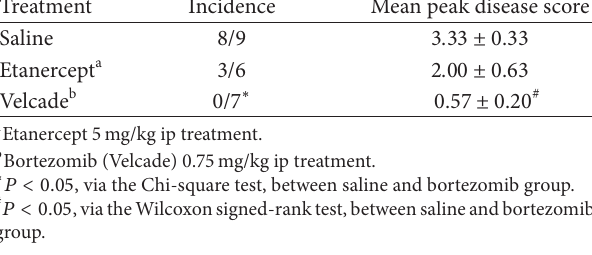
Table 2: Effect of etanercept versus bortezomib (Velcade) on EAU. Treatment Incidence Mean peak disease